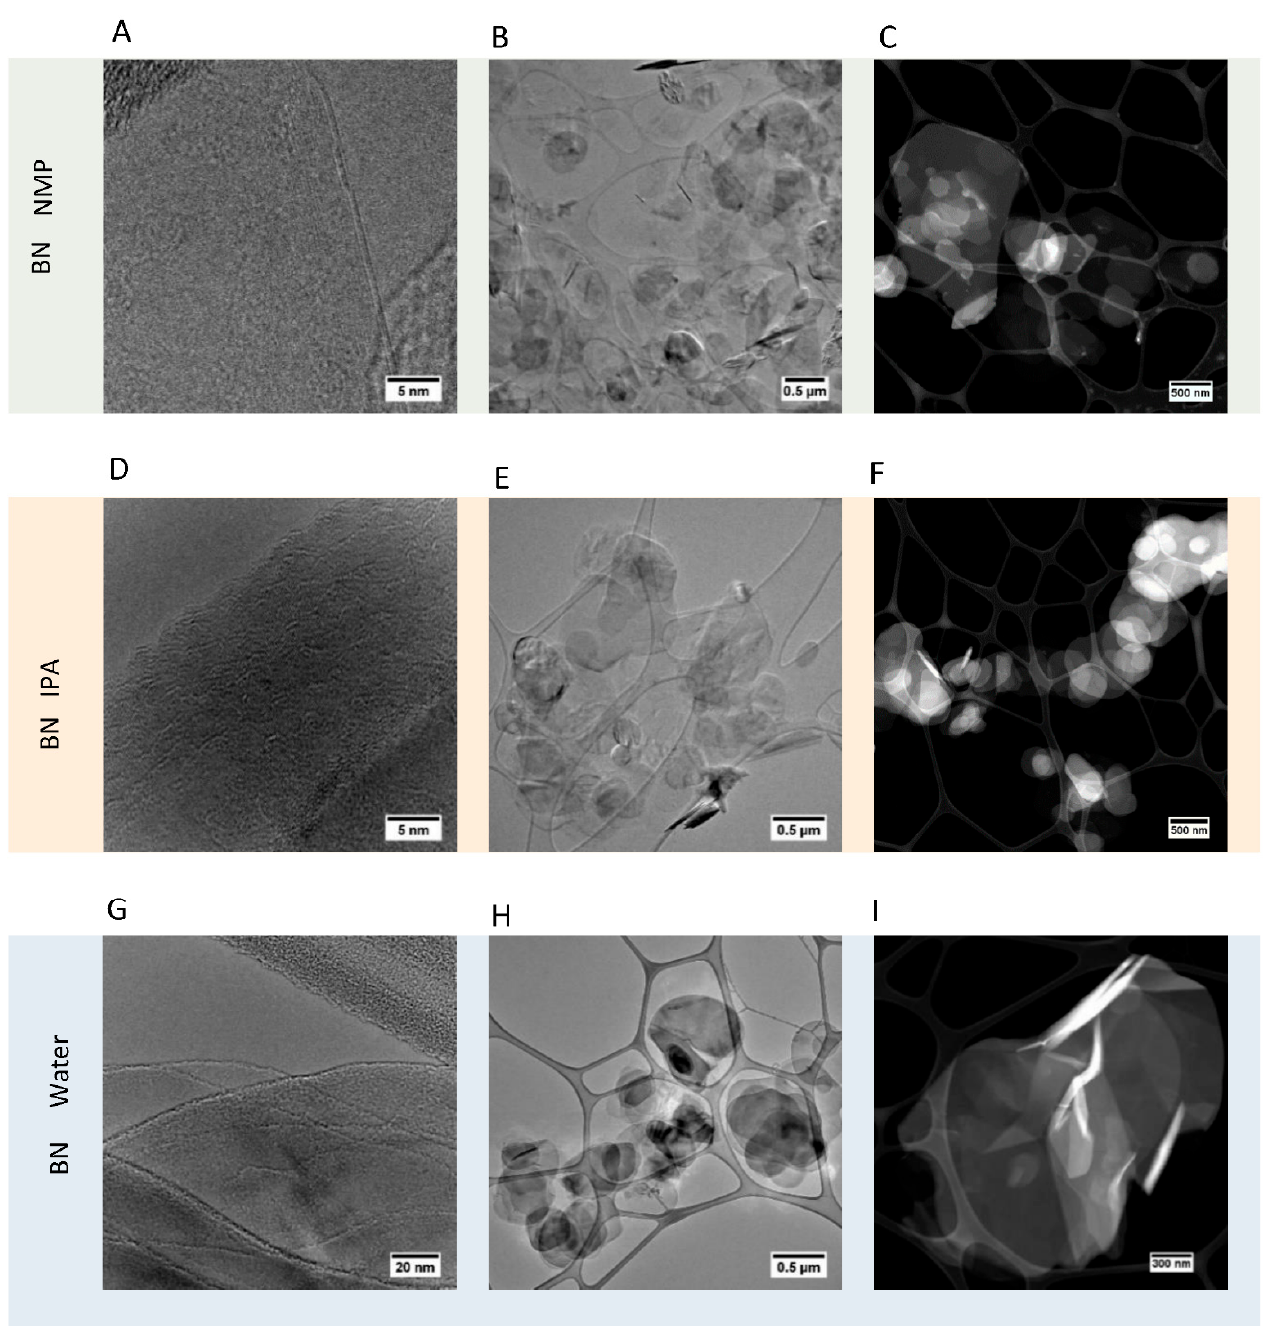
Figure 3. TEM ( A , B , D , E , G , H ) and STEM ( C , F , I ) images of 2D BN nanoflakes produced in NMP ( A – C ), IPA ( D – F ) and water ( G – I ).